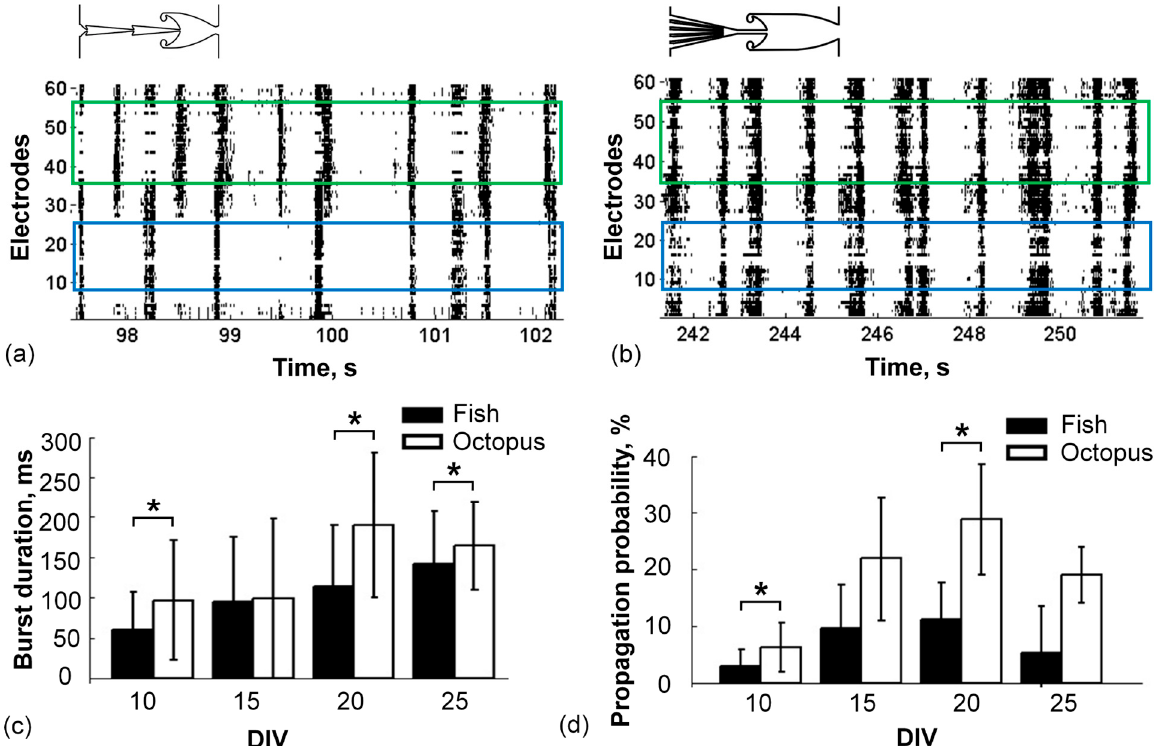
Figure 2. Propagation of spontaneous bursts between modules in two types of microchannels. ( a ) Raster plot of the activity in the Fish chip (see Methods for details). Some of the bursts propagated from the Source to the Target module. A blue box indicates the Source module, green box—the Target module. ( b ) Raster plot of the activity in the Octopus chip. Most of the bursts propagated from the Source to the Target module. ( c ) Mean (± standard deviation) burst durations recorded in the Source module of the Fish (black, n = 10 cultures) and the Octopus chip (white, n = 4 cultures) during culture development from 10 DIV to 25 DIV. ( d ) Probability of burst propagation from the Source to the Target module in the Fish and the Octopus chips. Mann–Whitney test, p < 0.05 (*).